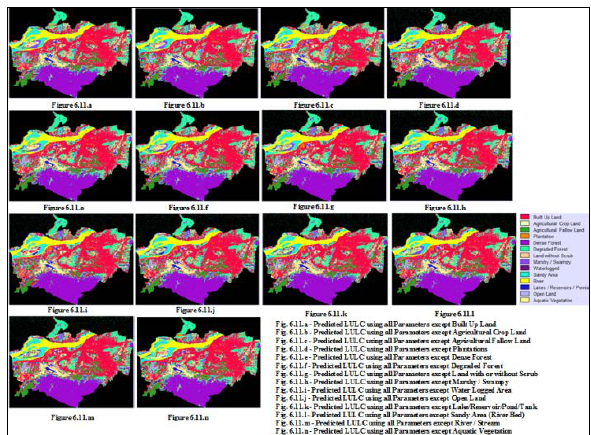
Figure 6.II: Predicted LULC of 2007 using all parameters except any one